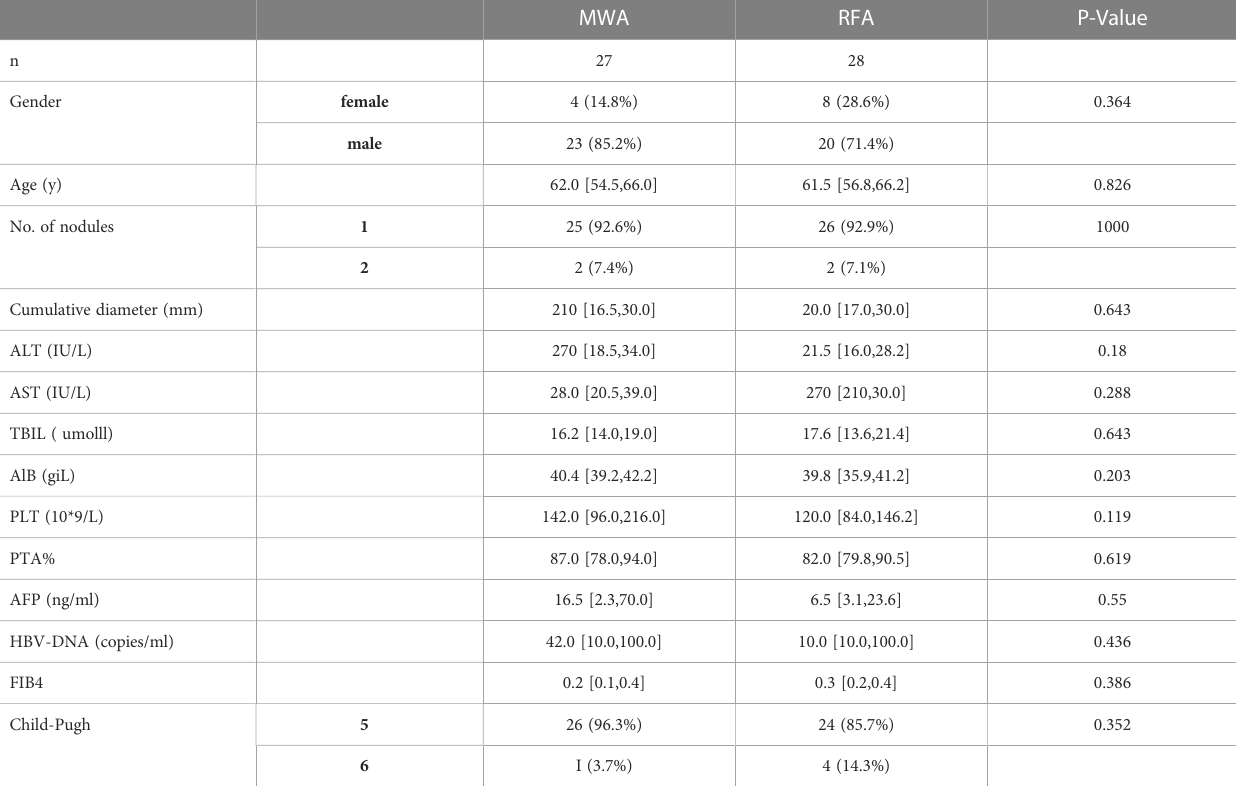
TABLE 1 Clinical characteristics of baseline patients in the RFA and MWA